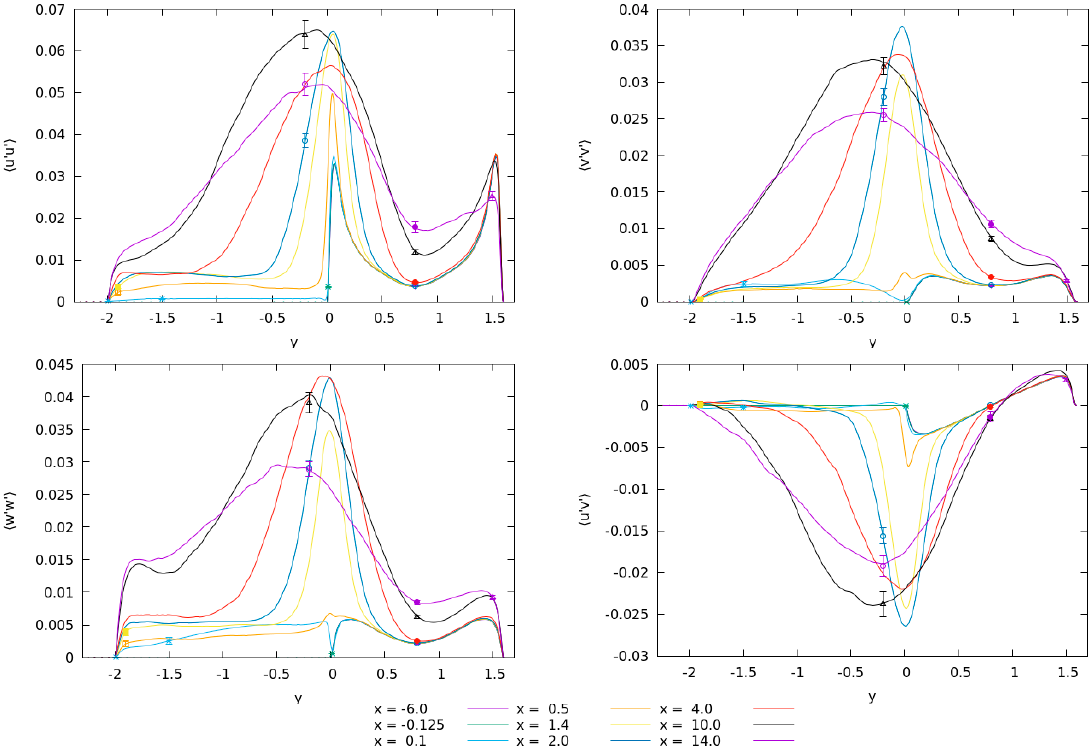
Figure 7. Profile of non-zero components of the Reynolds stress tensor at certain positions in the plane 𝑧 = 0